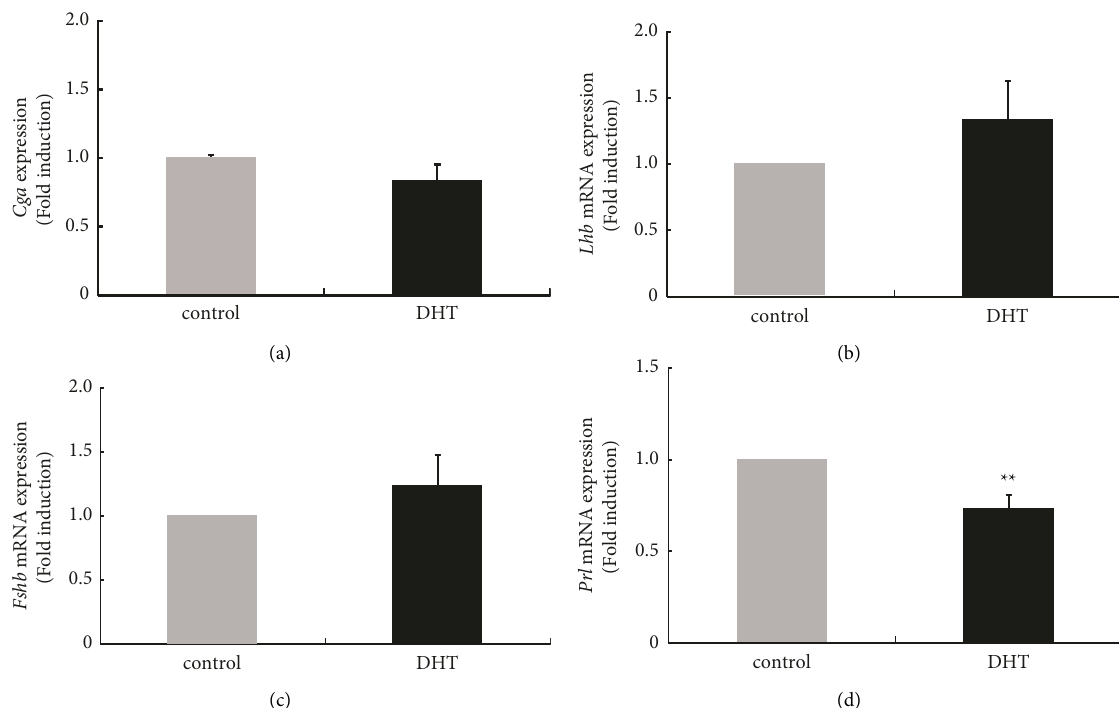
Figure 2: Effect of dihydrotestosterone (DHT) administration on gene expression of pituitary gonadotropin subunits and prolactin. Six- week-old female rats were injected subcutaneously with DHT (5mg/kg/day) daily for 7 days. After the rats were euthanized, the anterior pituitary was removed from nontreated ( n � 4) and DHT-treated rats ( n � 4), and then, mRNA was extracted from the anterior pituitary tissue and reverse transcribed. The mRNA levels of Cga (a), Lhb (b), and Fshb (c) subunits and prolactin were measured by quantitative RT- PCR. Samples from each experimental group were run in duplicate and normalized to the mRNA levels of the housekeeping gene Gapdh. The results are expressed as fold induction over the control and presented as the mean ± SEM. ∗∗ P < 0 . 01 versus